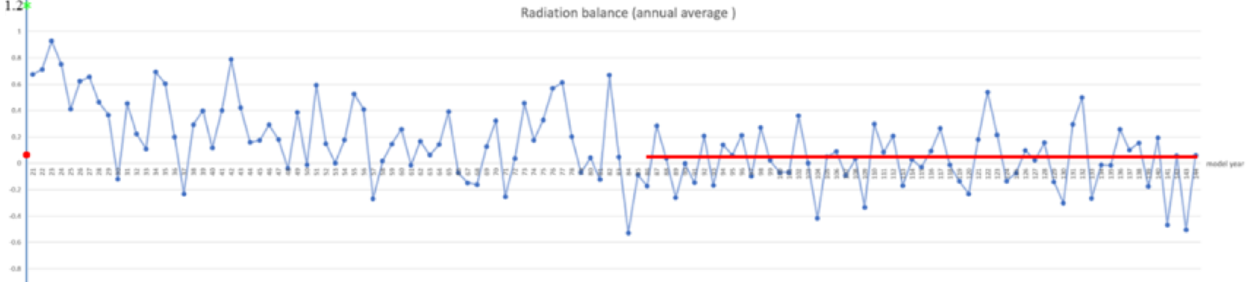
Figure 12. Time series of annual mean global average radiation balance at the top of the atmosphere (difference of shortwave radiation in and longwave radiation out). The red line marks the time average over 85 to 142 years as a value of 0.05Wm − 2 . The green dot (1.2Wm − 2 ) marks the initial value when the model starts from the default initial conditions, while the red dot marks the last 5-year mean value (0.07Wm − 2 ) after the model finishes the 20-year integration on the Intel(TAMU) machine.